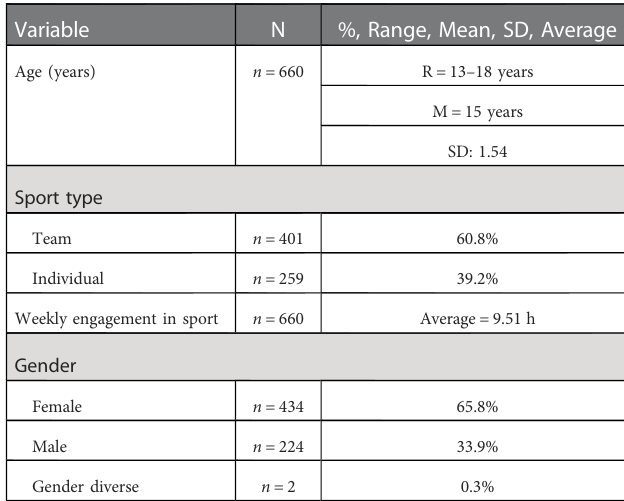
Table 2 . No independent variables had a statistically signi fi cant effect on decreased odds of supplement